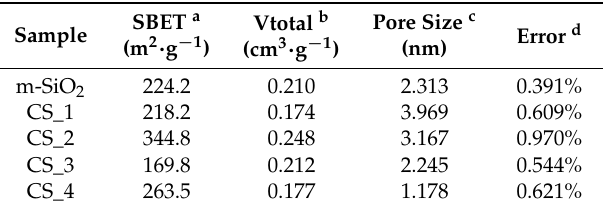
Table 1. Texture parameters of carbon spheres with different times of synthesis. SBET—Brunauer– Emmett–Teller surface area; Vtotal—total pore volume; m-SiO 2 —mesoporous silica; CS_1–4—carbon spheres with 1–4 h of chemical vapor deposition.